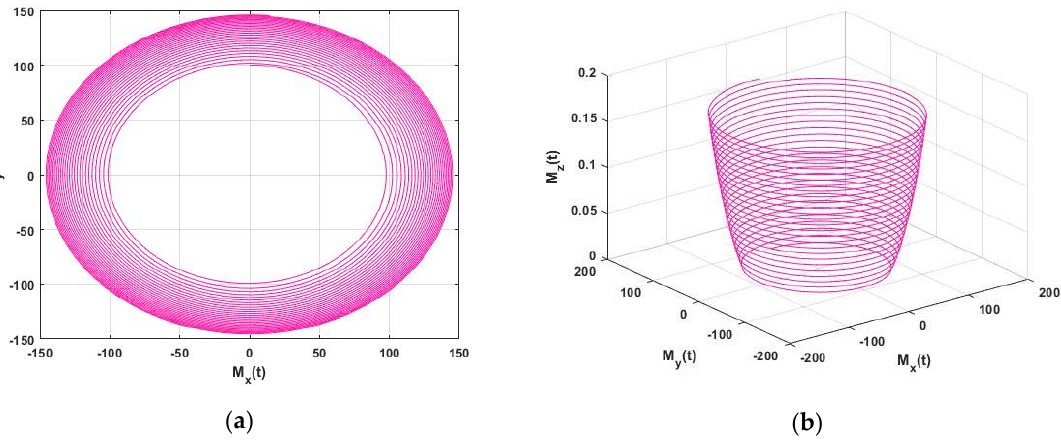
Figure 2. Approximate solution ( a ) 2D Plot and ( b ) 3D Plot of the FNMRF system for α = β = η = (cid:0) (cid:1) = ( M x ( 0 ) , M y ( 0 ) , M z ( 0 ) 1.03165 and initial condition 0,100,0 ) for T sim = 0.2